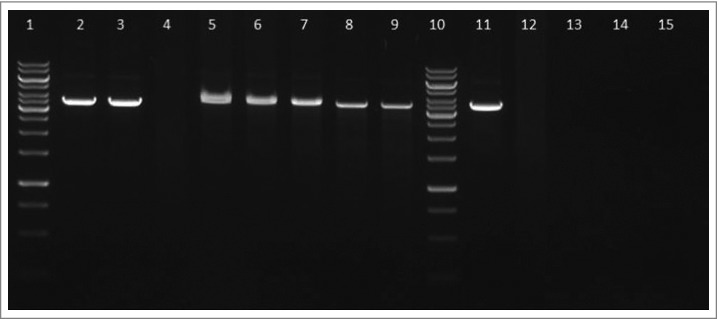
FtHU protects DNA from oxidative damage. The ability of FtHU to protect DNA from free hydroxyl radicals was tested. Samples were analyzed on 1% agarose gel and visualized by SYBR®Safe DNA gel stain. BSA protein was used as a negative control. 1 and 10 standards, 2 DNA, 3 DNA + H2O2, 4 DNA + H2O2 + Fe2+ (166 μM), 5–9 DNA + H2O2 + FtHU + Fe2+ (0 μM, 166 μM, 333 μM, 666 μM, 1000 μM), 11–15 DNA + H2O2 + BSA + Fe2+ (0 μM, 166 μM, 333 μM, 666 μM, 1000 μM). Even in case of increasing concentrations of Fe2+ HU is able to protect DNA from reactive oxygen species.